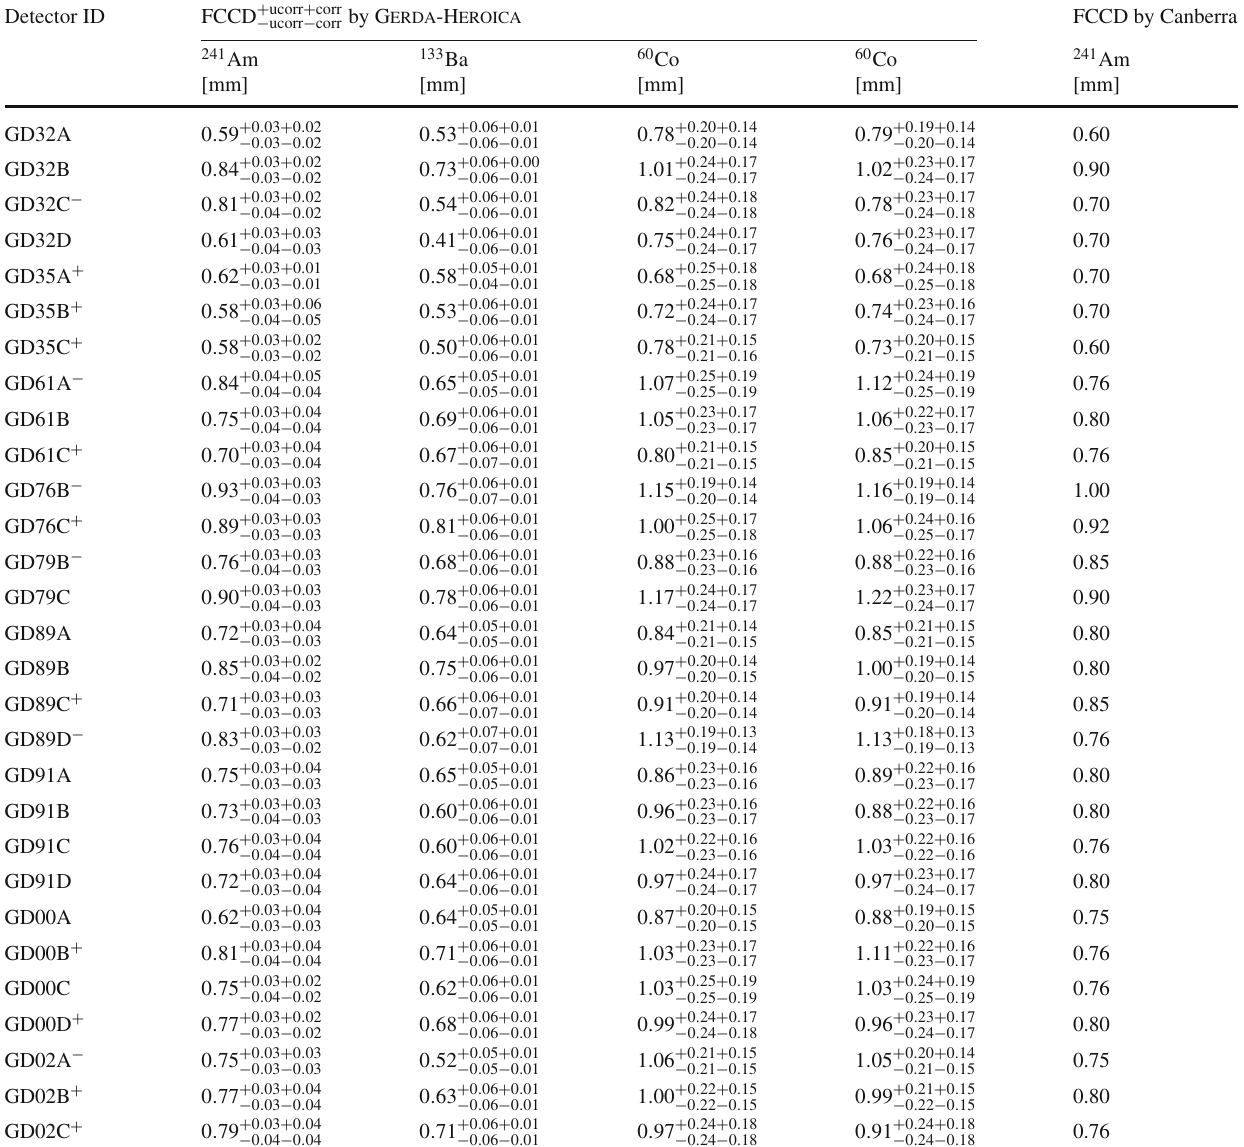
Table 8 FCCD results of the 29 well working Gerda Phase II BEGe detectors, as determined directly after diode production in vacuum croystats and using different probes. The spectra of the 241 Am and 133 Ba source measurements have been evaluated with a fitting method, while the 60 Co γ lines have been determined with a counting